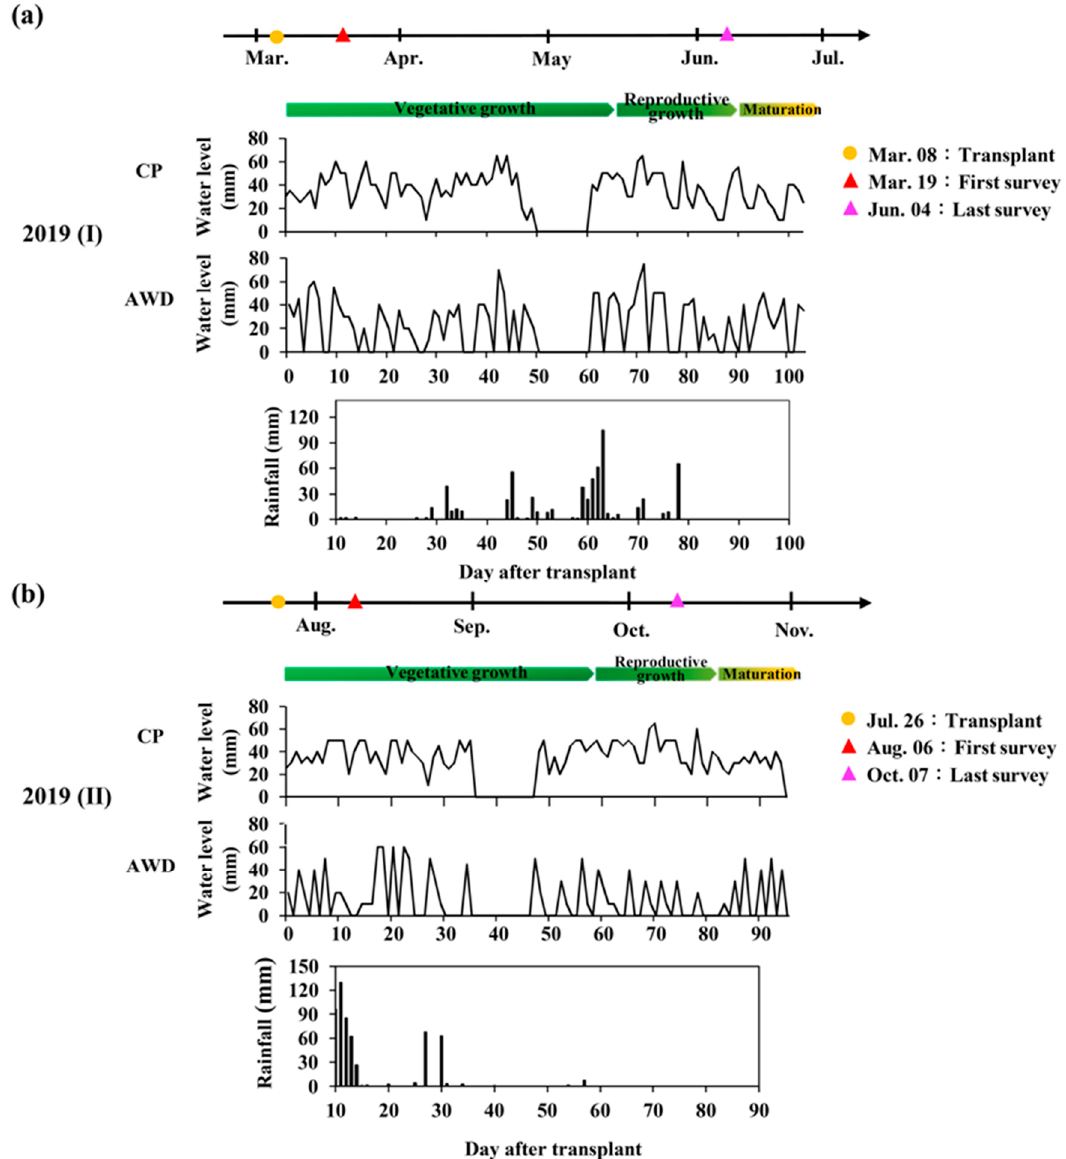
Figure 9. The cultivation calendar of rice cultivar TNG71 and the variation of water level and rainfall during days after transplant under different water treatments in ( a ) the first crop season; and ( b ) the second crop season.